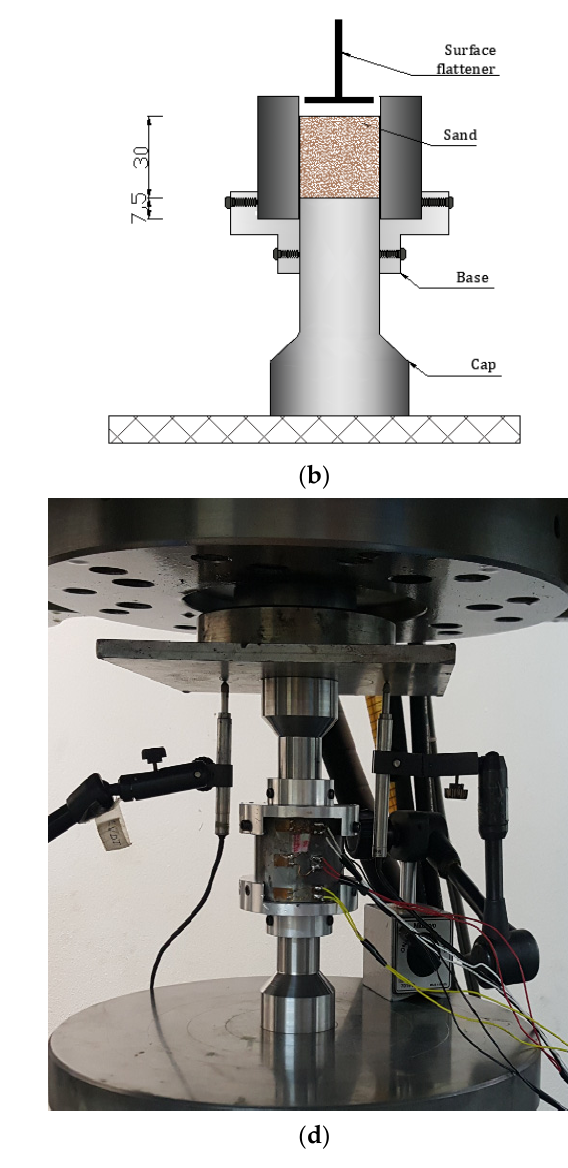
Figure 10. Sample preparation: ( a ) Sample height definition by means of dummy steel sample; ( b ) Pouring sand materials inside the confinement ring; ( c ) Final configuration; ( d ) Setup ready for test.